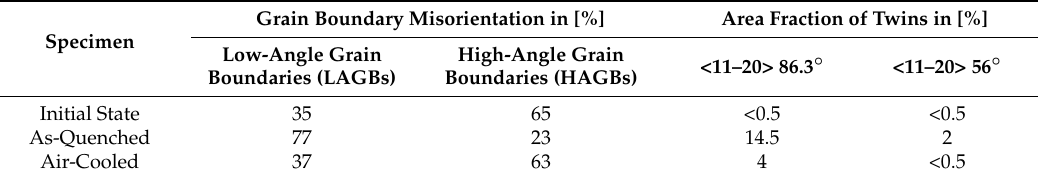
Figure 3. ( a – c ) Grain boundaries’ misorientation and twin boundaries (TBs); ( d – f ) misorientation angle distribution histograms and ( g – i ) (0002) pole figures (PF); from ( a , d , g ) the initial state, ( b , e , h ) the as-quenched and ( c , f , i ) the air-cooled specimens. Misorientation angles are marked based on the color-code bar right of Figure 3c. ED and TD, respectively, stand for the extrusion direction and the transverse direction. Table 1. Grain-boundaries’ misorientation, area fraction of <1120> tension and compression twins.